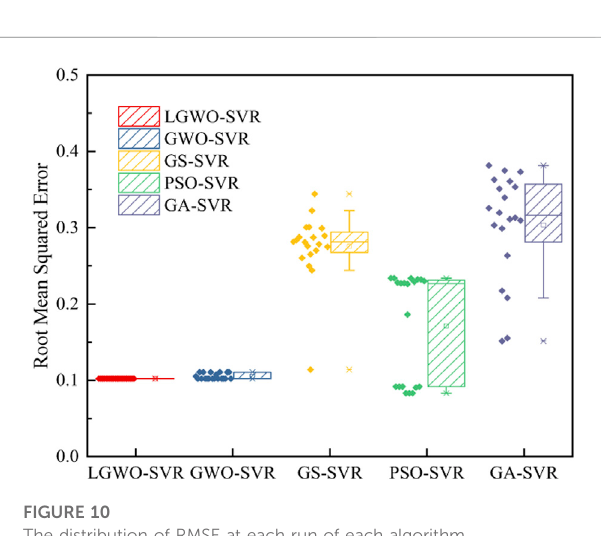
FIGURE 12 The distribution of MAE at each run of each algorithm.